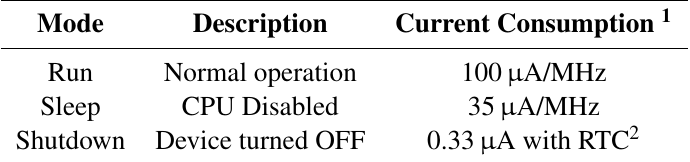
Table 3. Current consumption of the microcontroller during various modes of operation.